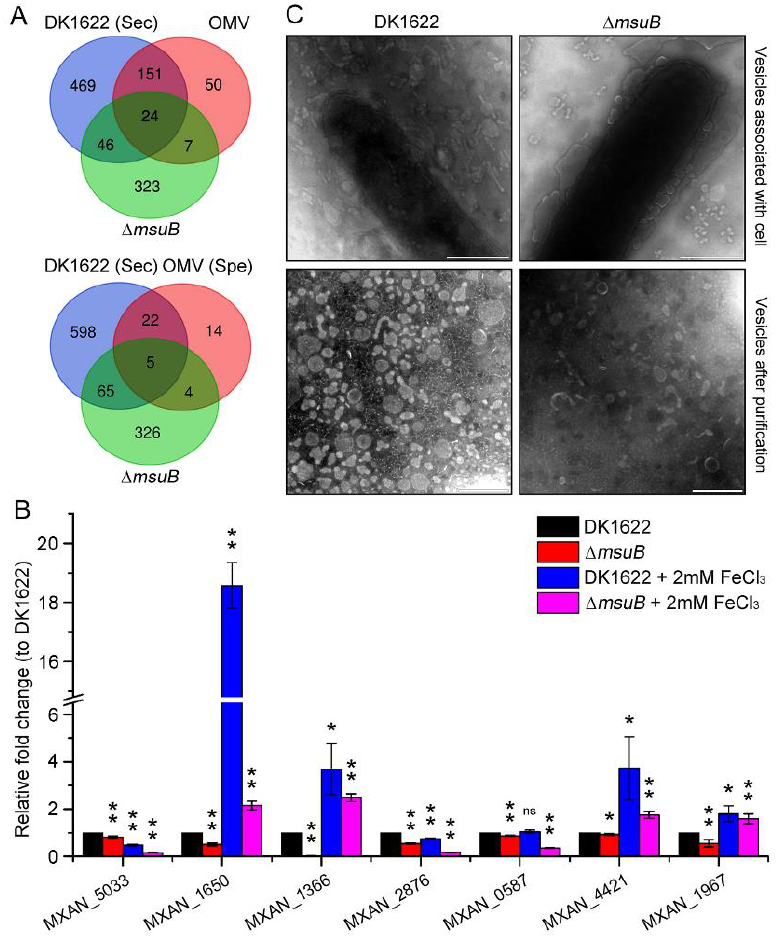
Figure 6. Effects of msuB deletion on the expression of OMV-specific proteins in M. xanthus . ( A ) Venn diagram analysis of DEGs and the genes encoding secretion proteins (DK1622) and OMV proteins. ( B ) DK1622 and ∆ msuB mutants were grown in CTT medium or CTT medium with 2 mM FeCl 3 for 24 h at 30 ◦ C. The sample was harvested by centrifuging 12,000 × g at 4 ◦ C and total RNA was extracted for detecting the expression of OMV related-genes, which were normalized to the expression of gapA . * p -value < 0.05; ** p -value < 0.01 compared with DK1622; ns, not significant. ( C ) DK1622 and the ∆ msuB mutant were grown in a CTT medium for 24 h at 30 ◦ C. OMVs were observed by transmission electron microscopy (TEM) (scale bar = 500 nm) (top panel). OMVs were isolated by centrifuging at 150,000 × g and were observed by transmission electron microscopy (TEM) (scale bar = 200 nm) (bottom panel). Table 1. OMV-specific expression genes. No. Old Locus Locus Gene